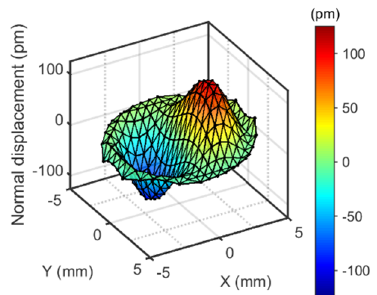
Figure 4. The operating deflection shape obtained after Zernike filtering the raw ODS from Figure 3(C). The extracted amplitude is 120 pm (see Table 1).